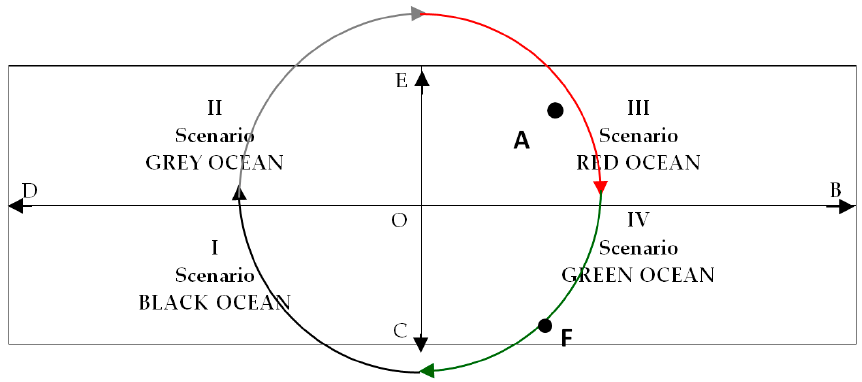
Figure 3. Four-ocean PES scenario matrix. Source: own study.